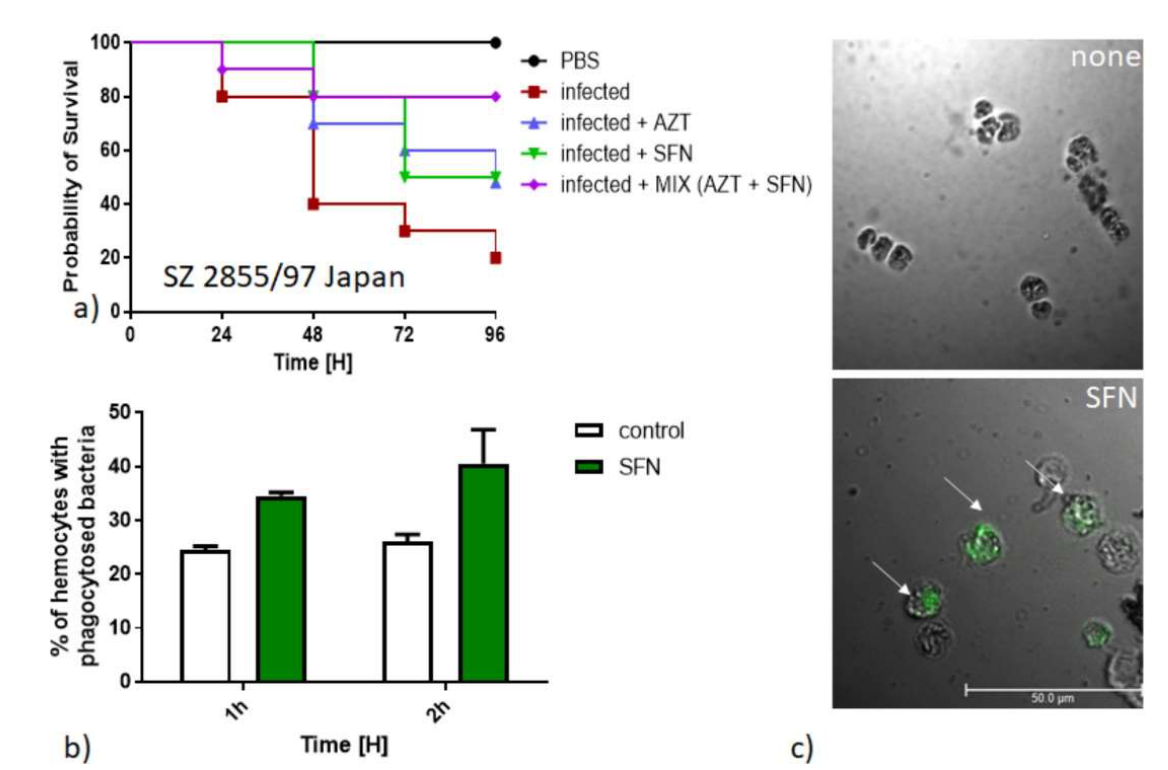
Figure 5. SFN inhibits virulence of S. dysenteriae in G. mellonella surrogate model. ( a ) The survival of larvae was assessed at indicated times after injection of PBS (control) or 10 8 of bacteria. The azithromycin and SFN alone or their combination were administrated 1 h after infection at a concentration indicated and development of the infection was observed during the next 96 h. ( b ) In vivo phagocytosis ratio of FITC-labelled bacteria. ( c ) Representative fluorescent microscopy images of bacteria phagocytosed by hemocytes (indicated by white arrows) from uninfected (PBS) and infected and SFN-treated larvae.